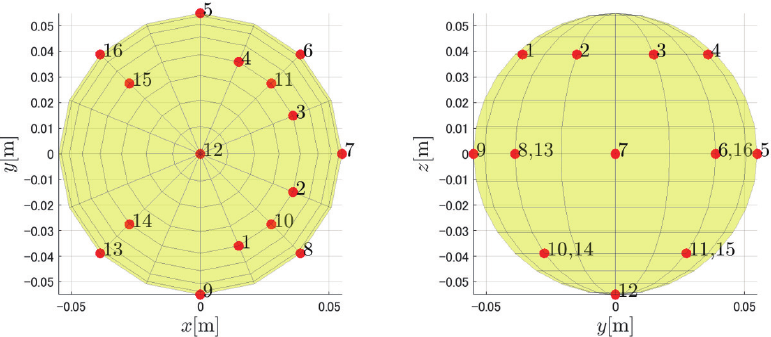
Figure 4. Microphone placement in a microphone